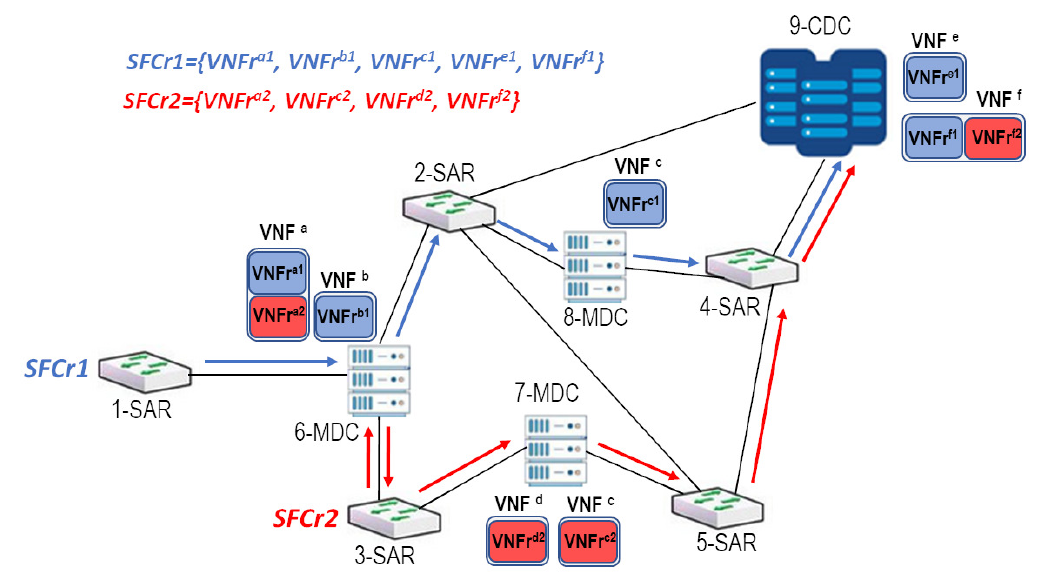
Figure 1. Problem outline using the example described in